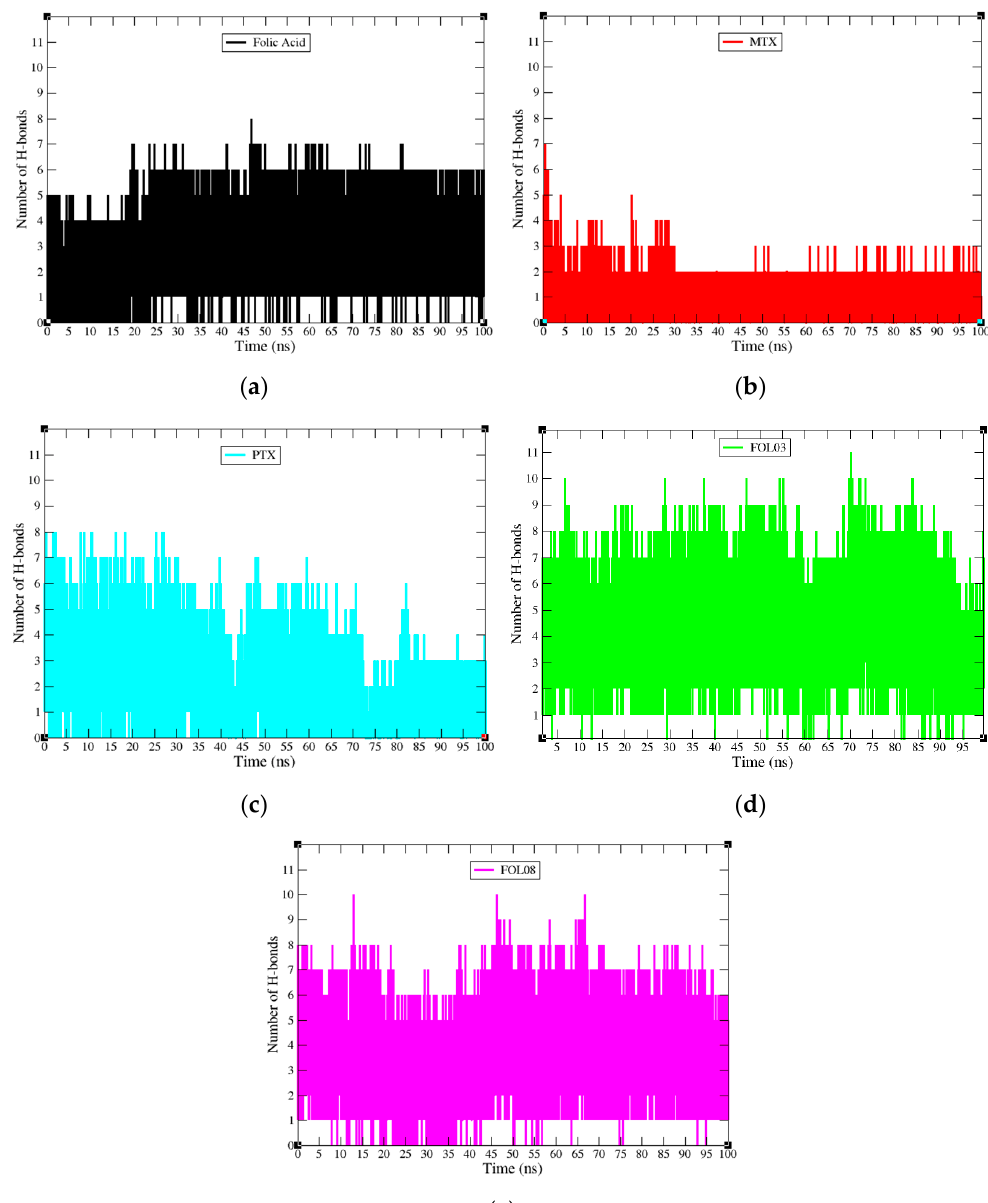
Figure 14. Hydrogen bond profiles during the 100 ns molecular dynamics simulations for complexes ( a ) FA (black), ( b ) MTX (red), ( c ) PTX (cyan) ( d ) FOL03 (green), and ( e ) FOL08 (magenta). 2.3.6. General Effects of the Binding of FOL03 and FOL08 Inside FR α From molecular docking, we have identified tetrazole- and benzothiophene-substituted analogs of FA, which have more negative binding energy (FOL03, − 16.83 kcal/mol and FOL08, − 16.24 kcal/mol, respectively) compared to FA ( − 13.20 kcal/mol), MTX ( − 11.87 kcal/mol), and PTX ( − 14.05 kcal/mol). These values are in agreement with the free binding energy calculated from MM-PBSA where FOL03 and FOL08 showed the most favorable binding energy ( − 73.62 and − 79.68 kcal/mol, respectively) compared to FA, MTX, and PTX ( − 59.59, − 45.12, and − 30.11 kcal/mol,